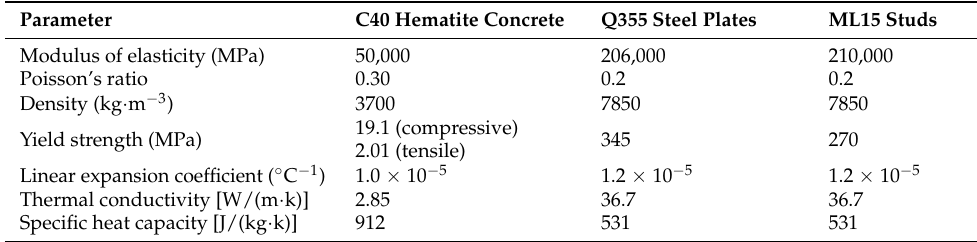
Table 1. Mechanical and thermal parameters of materials.